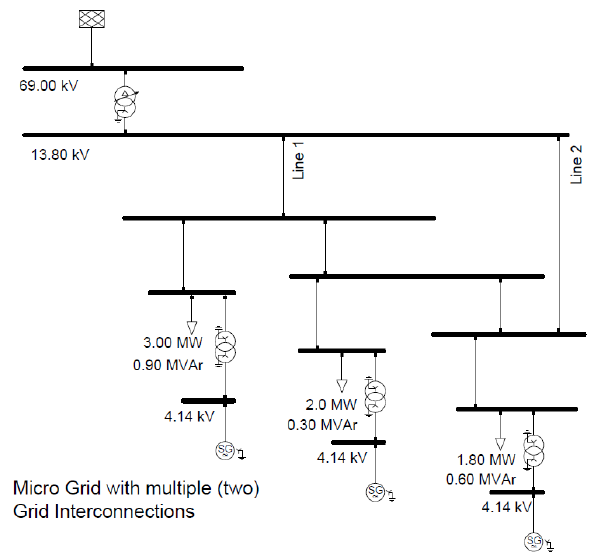
Figure 6. Network model.